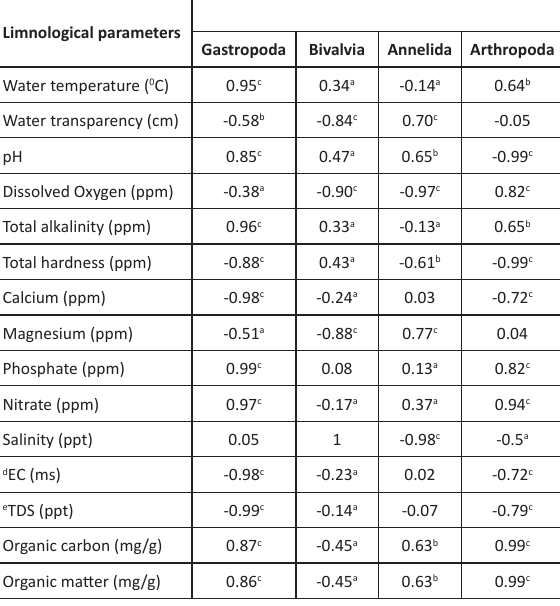
Table 6. Correlation among limnological parameters and benthic macroinvertebrate density.